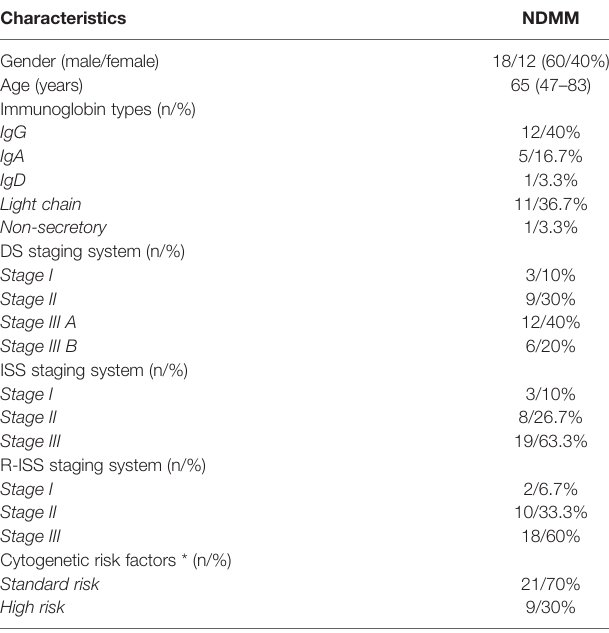
TABLE 1 | General characteristics of the patients with newly diagnosed MM.